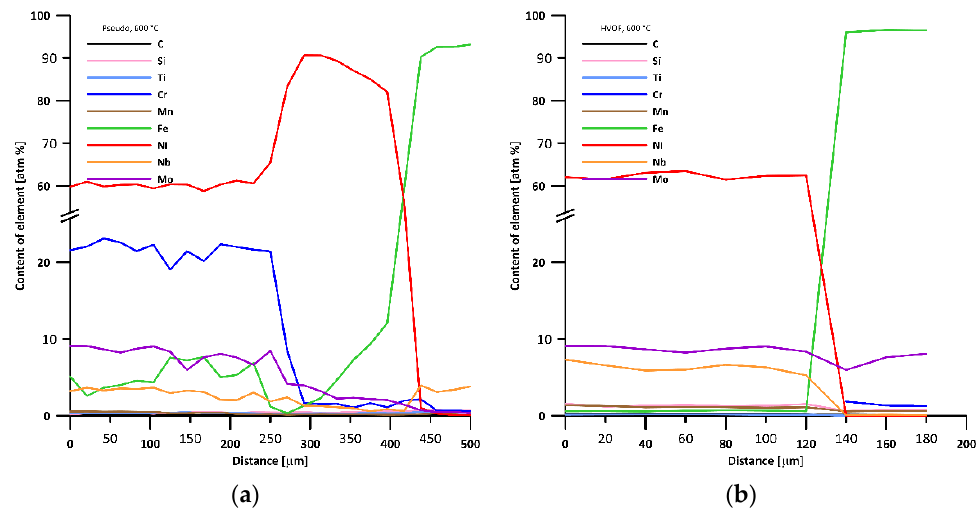
Figure 12. Chemical analysis of the coatings performed by EMPA with 20 μ m steps (each point is the average of 10 separate measurements). ( a ) TWAS—pseudo ‐ alloy; ( b ) HVOF.